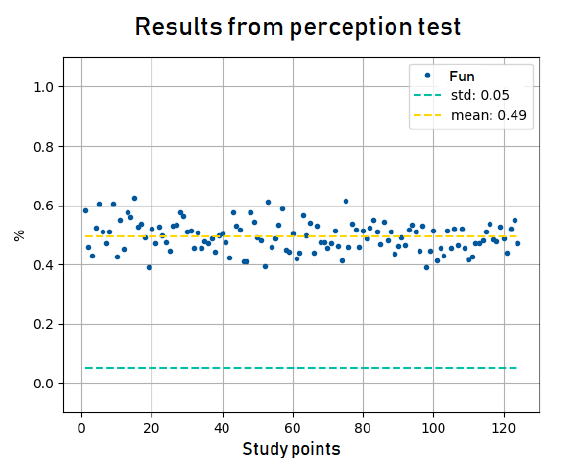
Figure 7. Fun perceived from the points of study.